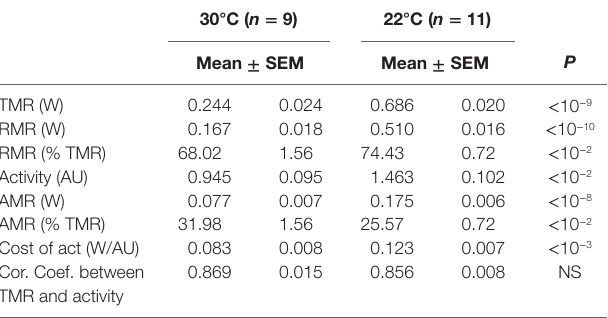
TaBle 2 | components of energy expenditure in ad libitum fed mice.